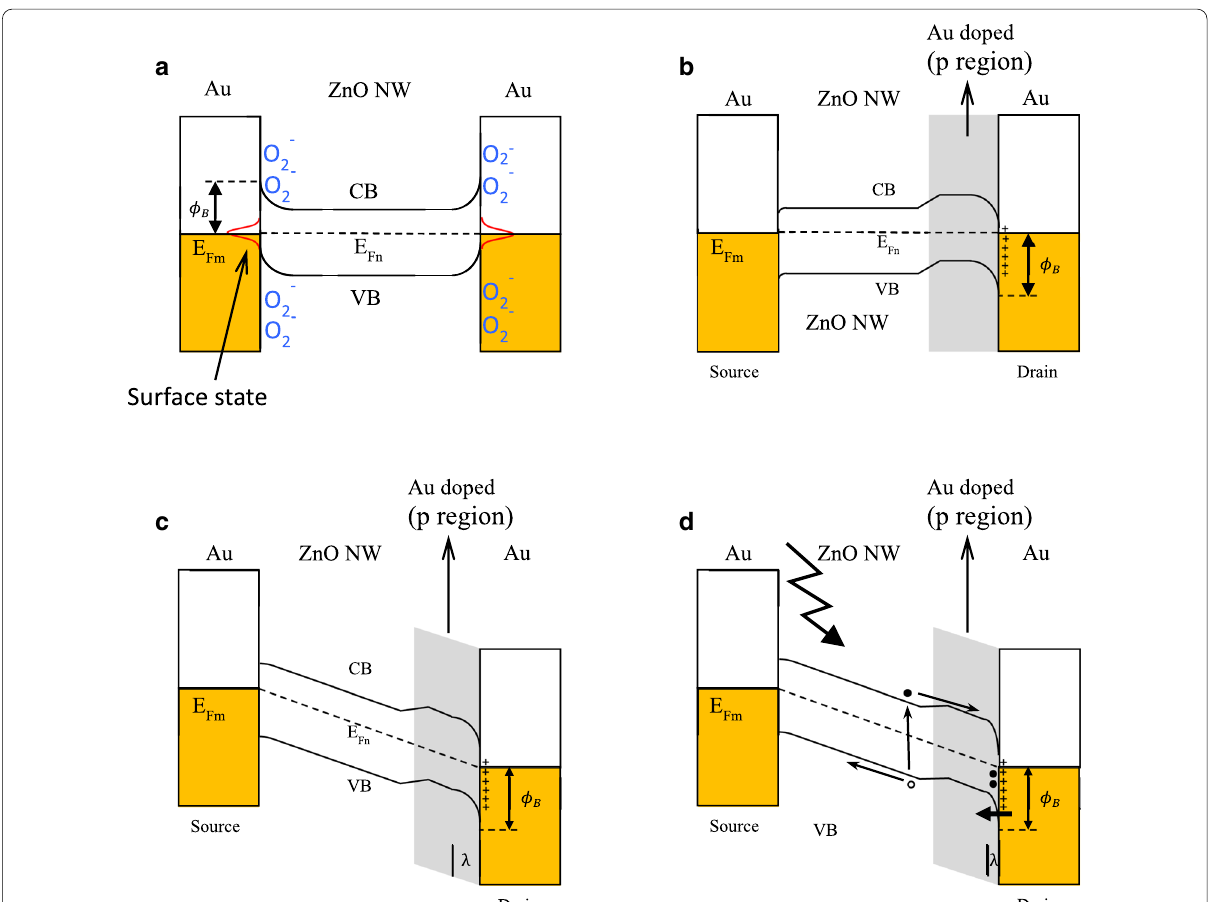
Fig. 8 Band diagrams of Au/ZnO/Au structure. a The device formed by the DEP alignment process with the applied DC bias of less than 2 V. b The device formed by the DEP alignment process with the applied DC bias of 3 V, c dark conditions under reverse bias and d under illumination with reverse bias. λ is the depletion